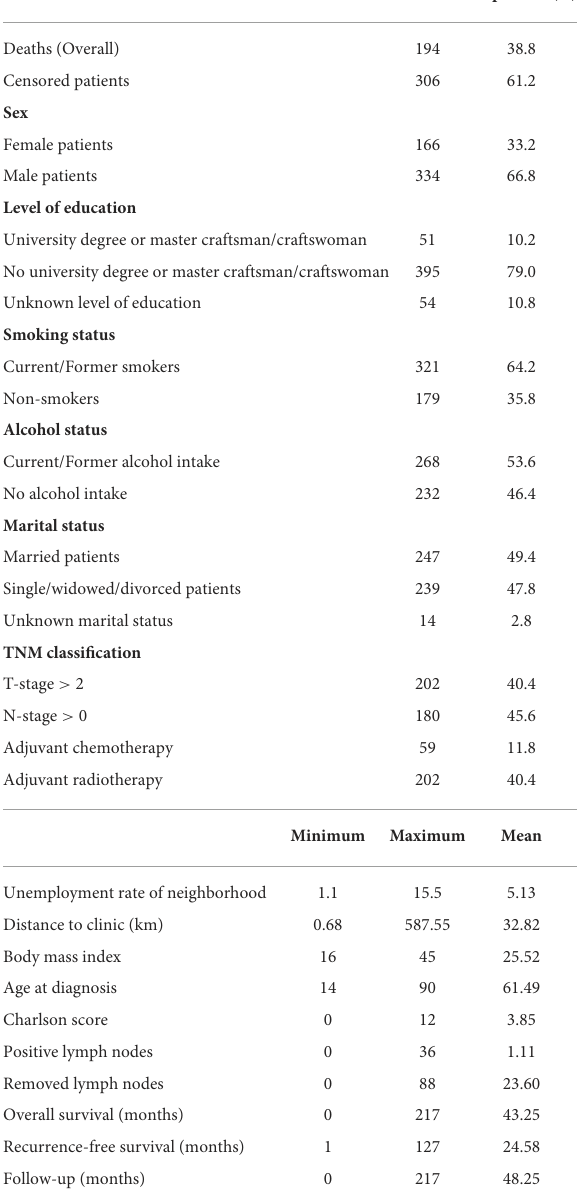
TABLE 1 Demographic data of the study